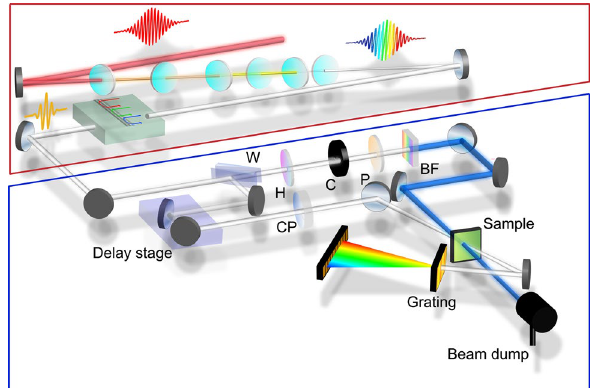
Figure 1. Scheme of the MPC-TAS system used in this paper, with the MPC part indicated by the red box and the TAS part indicated by the blue box. CM, chirped mirrors; W, wedge pair; H, half-wave plate; C, chopper; P, wire-grid polarizer; SF, short-pass filter; CP, compensation